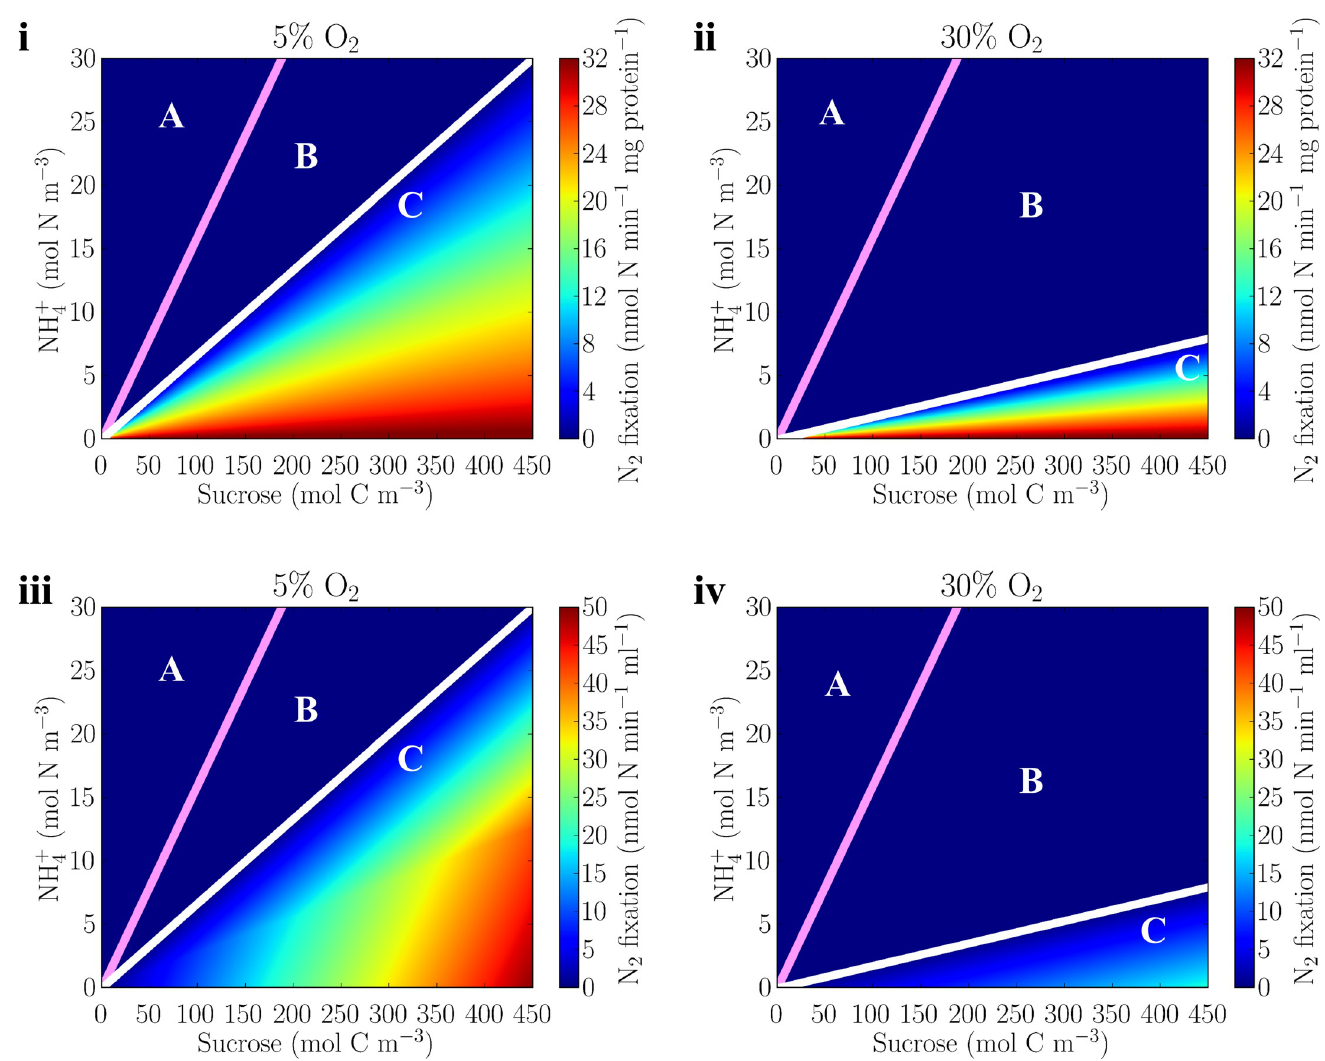
Fig 6. Nitrogen fixation rate under different sucrose, ammonium, and oxygen regimes. Nitrogen fixation shown per protein (i and ii) and per volume (iii and iv) at oxygen saturations of 5% (i and iii) and 30% (ii and iv). Dilution rate is constant at 0.15 h -1 . Pink and white lines indicate the transitions from carbohydrate limited (A) to ammonium limited (B), and from ammonium assimilation only (A, B) to ammonium assimilation and nitrogen fixation (C) regimes respectively; Regimes (A) ~ (C) here represent cellular states (A) ~ (C) defined in Fig 3 respectively. Here 100% O 2 equals 225 μ M thus approximately O 2 saturation under normal air composition at 30˚C. The net growth isocline (ZNGI) is much smaller than the scale of the axes here [34,41]and it is assumed small in this model; both ammonium and sucrose concentrations in the culture are much smaller than those in the incoming medium in the laboratory studies [34,41].